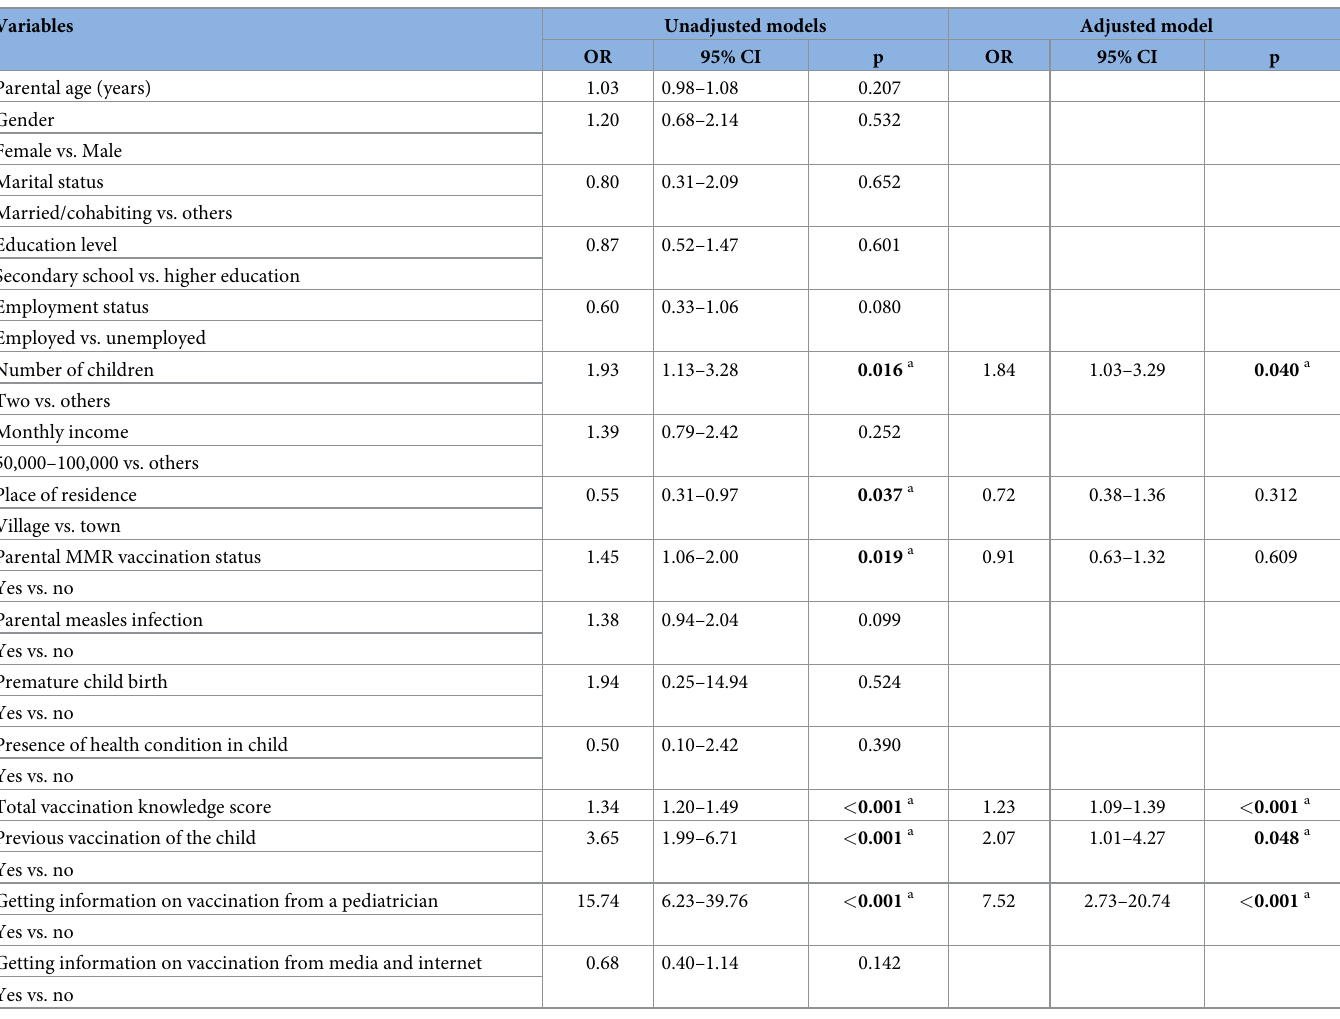
Table 3. Predictors of child’s MMR vaccination